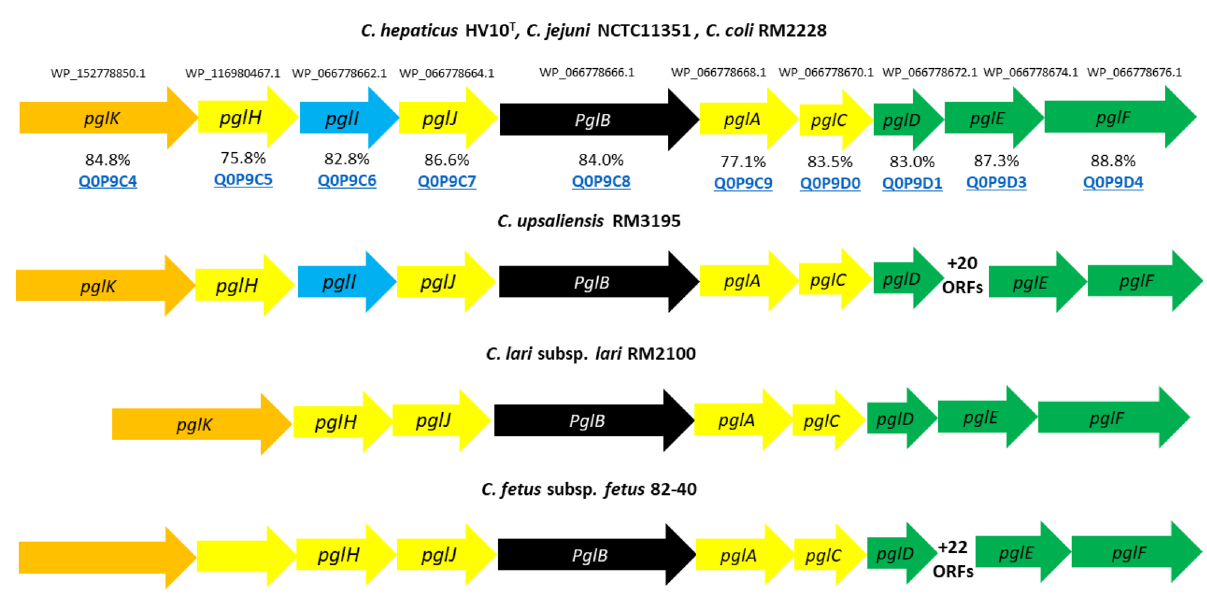
Figure 1. Comparison of pgl loci organisation in Campylobacter species. C. hepaticus HV10 T , C. jejuni NCTC 11351 and C. coli RM2228 share the same arrangement of genes in the pgl locus. The coding sequence accessions for each C. hepaticus HV10 T pgl gene are included above each gene and the individual gene products/protein identity (%) compared to C. jejuni subsp. jejuni NCTC11168 encoded gene products are stated below with the Uniprot entry accession number. The genetic organisation of this pgl locus has been compared to other more distantly related species (according to 17 ). Genes encoding glycosyltransferases are shown in yellow, pglB in black, genes involved in diNAcBAc synthesis in green, and flippase in